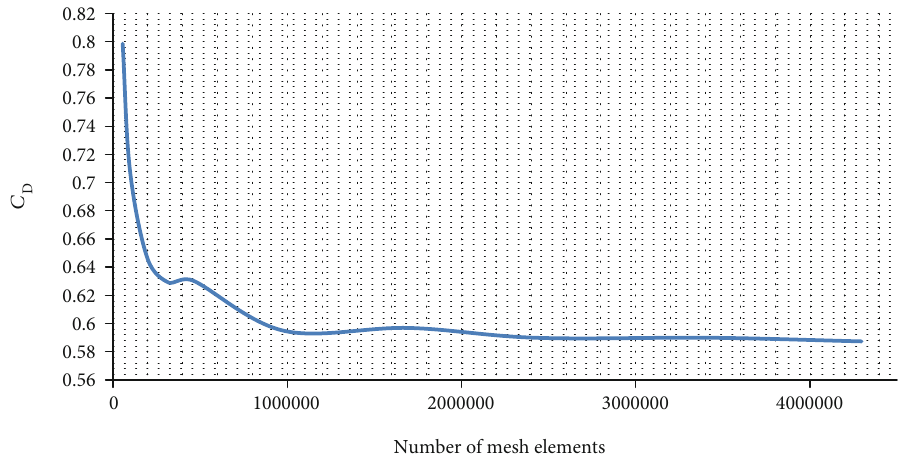
Figure 4: C D value with respect to the number of mesh elements for 2.5 Mach